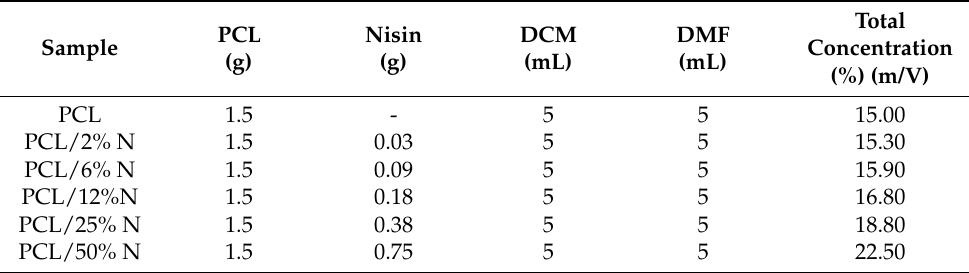
Table 1. Solutions prepared for electrospinning of PCL and PCL/nisin fibers (N—nisin, DCM, DMF—used